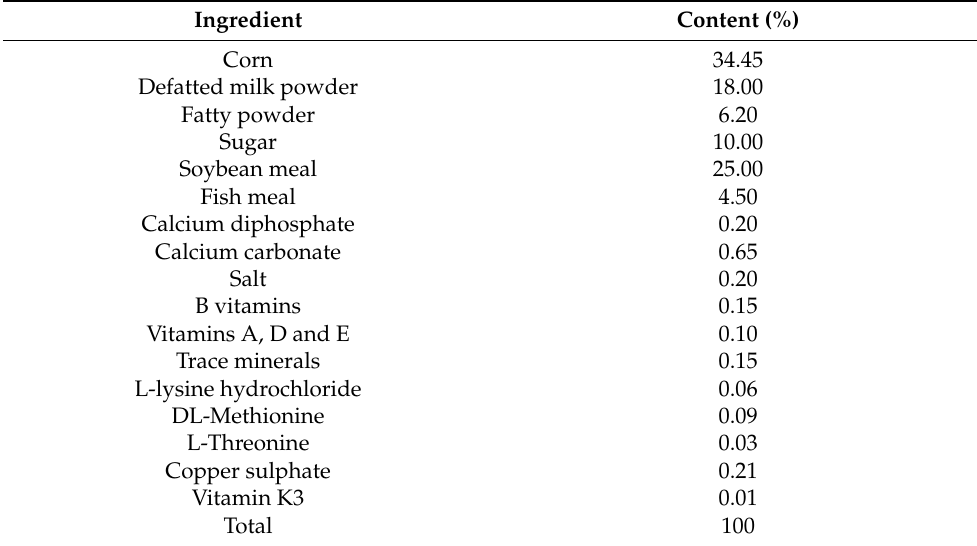
Table 3. Ingredients and chemical composition of basal diet (as-fed basis) 1 .